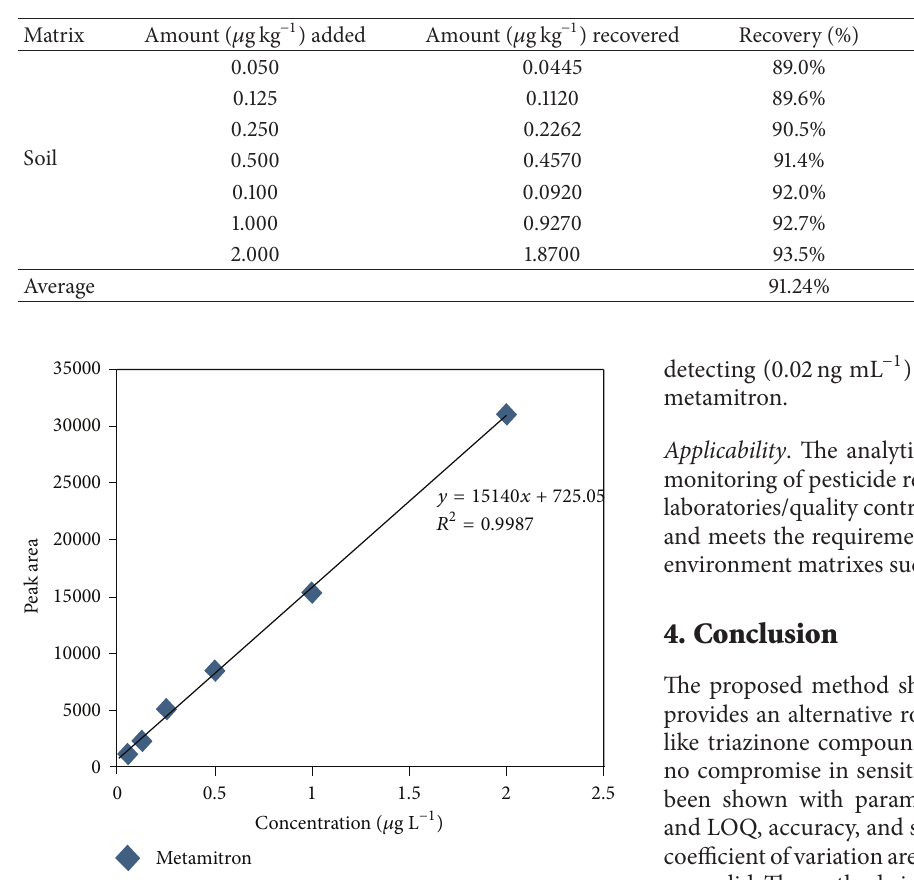
Table 1: Recovery, repeatability (RSDr), intermediate precision (RSDip), and linearity of the method.